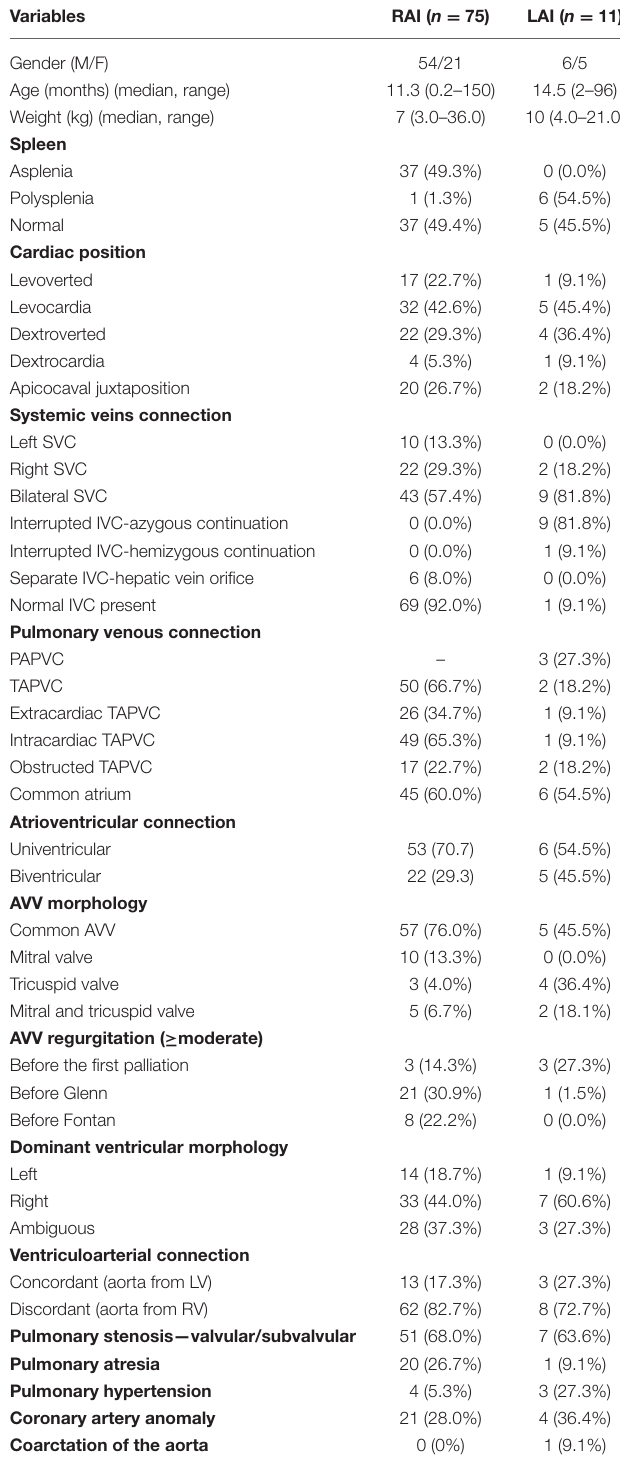
TABLE 1 | Demographic and anatomic characteristics of patients with atrial isomerism ( n = 86).